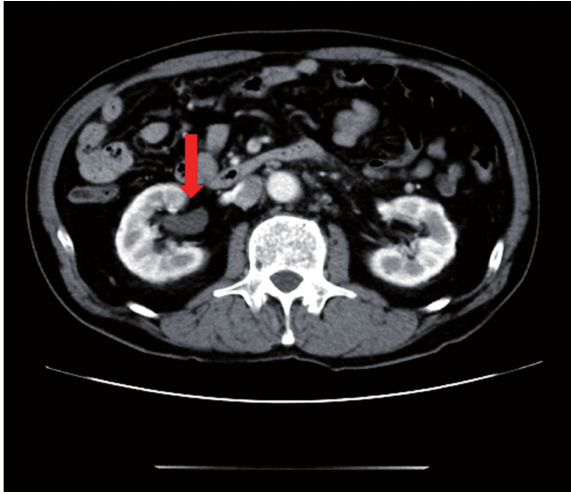
figure 1 - Enhanced computed tomography revealed a low density area surrounding the aorta at the level of the inferior mesenteric artery and the right total iliac artery.